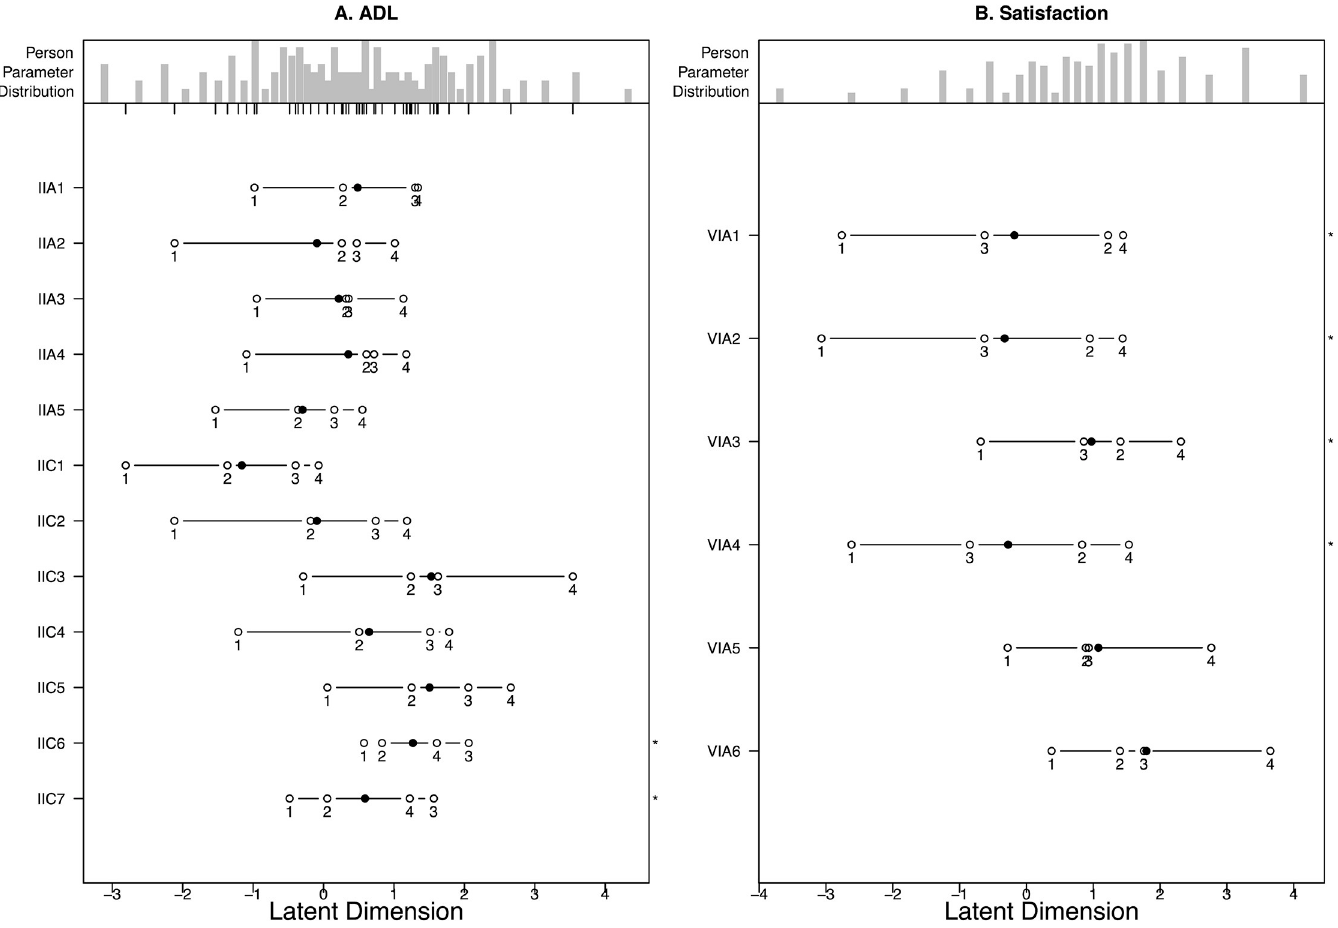
Fig 2. Disordered thresholds for ADLs (2a, left) and Satisfaction (2b, right). (Table 4). Satisfaction was unidimensional according to the Martin-Lo¨f test (p = 0.97) and no response dependency was observed in the residuals. Overall, after removing item 3 and col- lapsing disordered thresholds, Satisfaction showed excellent fit to the Rasch model.